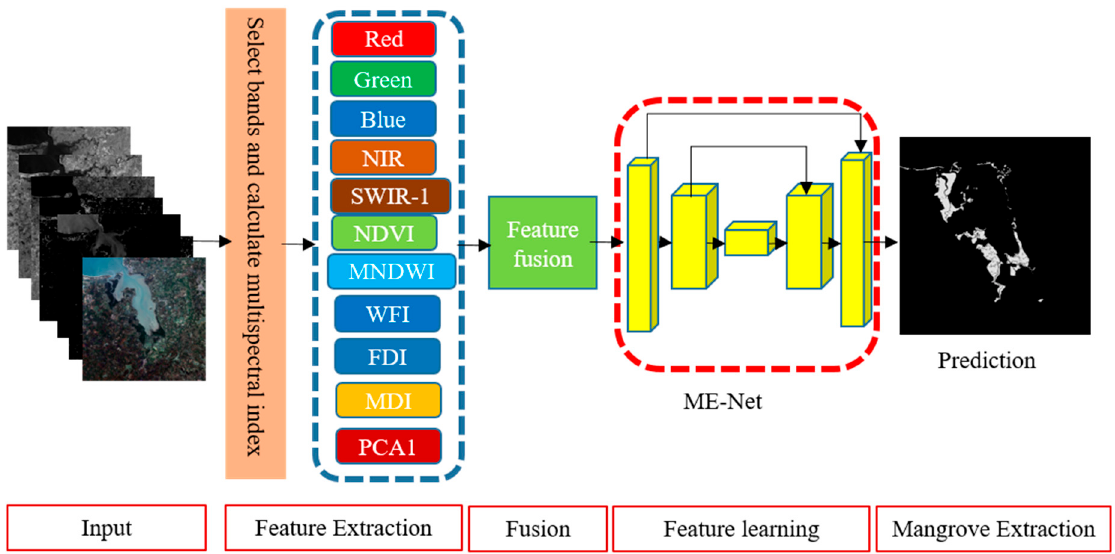
Figure 1. Segmentation framework of mangrove extraction using deep learning.